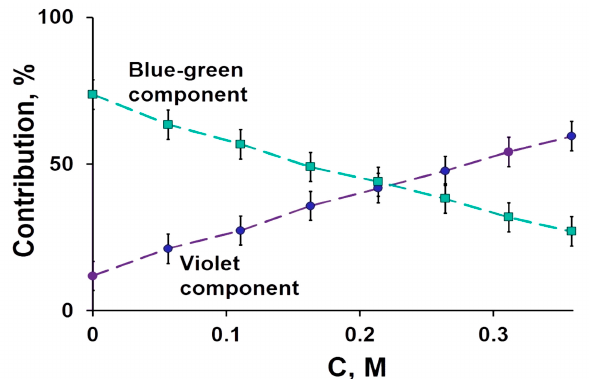
Figure 4. Contributions of spectral components to the fluorescence spectra of CLM-containing protein at different concentrations of glycerol, C.